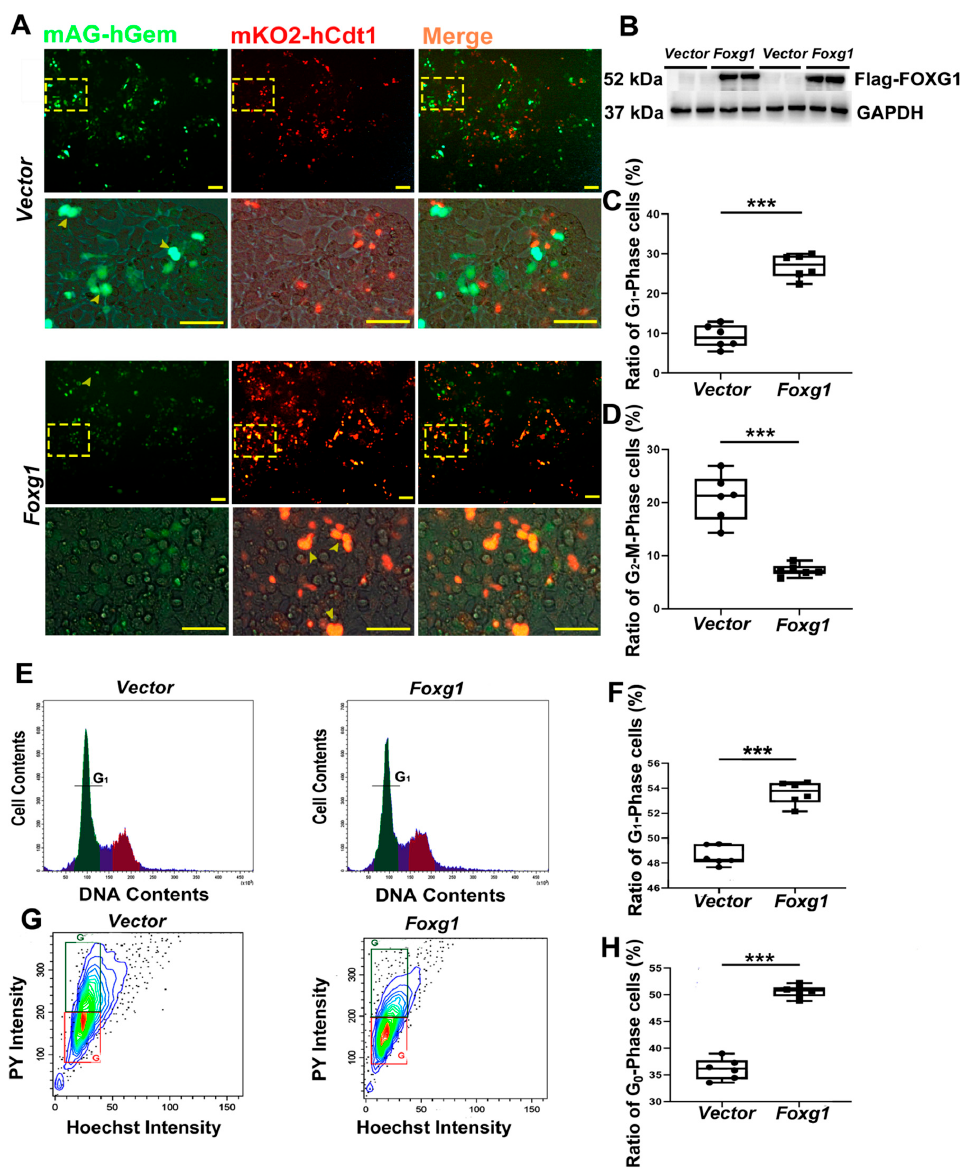
Figure 6. FOXG1 prolongs G 1 -phase length and promotes cell redistribution. FUCCI cells were cultured in 35 mm dishes for 24 h. The cells were transfected with vector or Foxg1 plasmid for 48 h. ( A , B ) Fluorescence images of mAG and mKO2 emission signals in vector or Foxg1 transfected 293T cells (Green = mAG; Red = mKO2) were disaplyed. Scale bar = 50 µ m. Ratio percent of ( C ) G 1 - and ( D ) G 2 -M phase cells were calculated using the formula [G 1 phase: mKO2 + cells/(mKO2